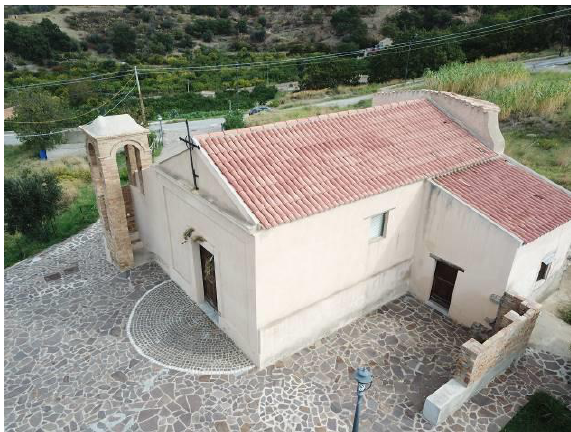
Figure 1. Sant’Antonio Abate Church